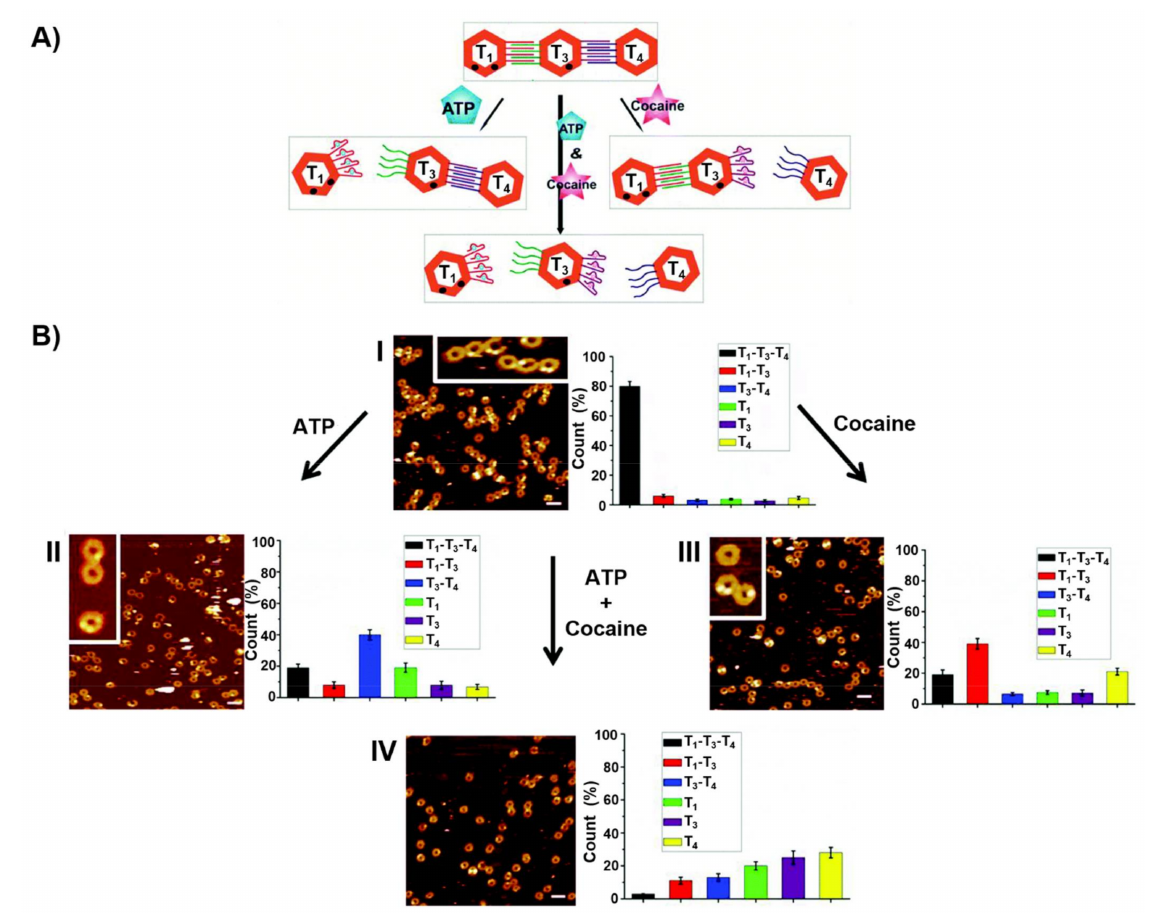
Figure 17. ( A ) Dictated triggered separation of an origami trimer using different aptamer interconnecting bridging units. Treatment of the origami trimer T 1 –T 3 –T 4 with ATP yield the separation of tile T 1 through the formation of the ATP/ATP aptamer complex and the intact T 3 –T 4 dimer. Subjecting the trimer to cocaine yield the T 1– T 3 dimer and separated tile T 4 through the formation of the cocaine/cocaine aptamer complex. Treatment of the trimer with cocaine and ATP led to the concomitant separation of the trimer to the monomer tiles T 1 , T 3 , T 4 . ( B ) AFM images corresponding to: Panel I—the origami trimer T 1 –T 3 –T 4 ; Panel II—the ATP triggered separation of the trimer T 1 –T 3 –T 4 into the monomer tile T 1 and the dimer tile T 3 –T 4 ; Panel III—the cocaine triggered separation of the trimer T 1 –T 3 –T 4 into the dimer tile T 1 –T 3 and the monomer tile T 4 ; Panel IV—the cocaine and ATP triggered separation of the trimer T 1 –T 3 –T 4 into the monomer tiles T 1 , T 3 , T 4 . The AFMimages are accompanied by statistical analysis of the percentage of the tiles. Reproduced with permission from ref. [216]. Copyright 2017 Royal Society of